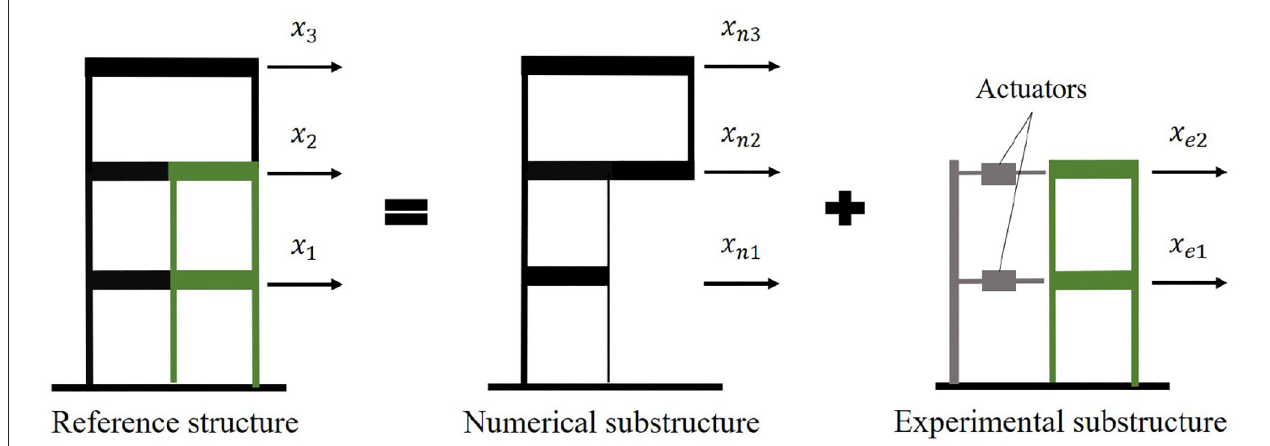
FIGURE 1 | Real-time hybrid simulation substructuring